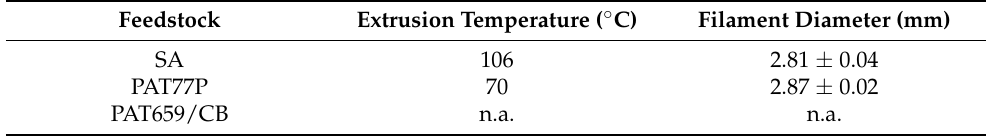
Table 4. Extruded PEG(8000)60/PMMA40 filaments (solid load 60 vol%).